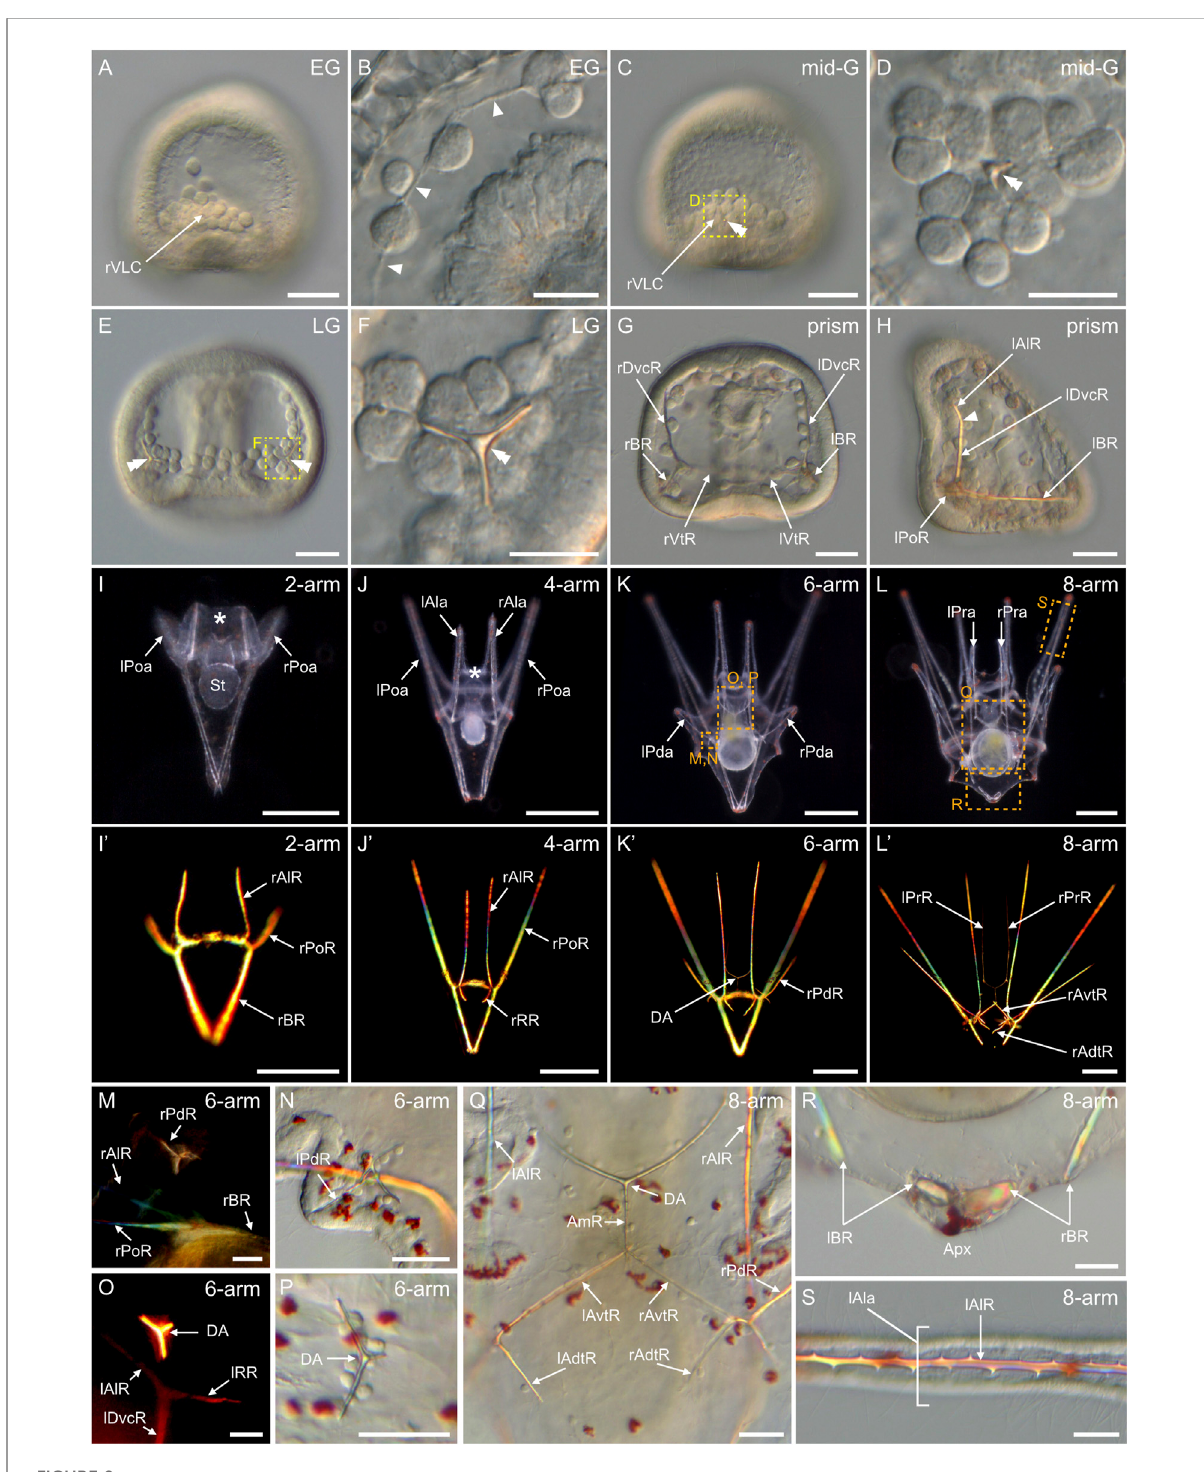
FIGURE 9 Skeletogenesis in Paracentrotus lividus during the embryonic and larval periods. Developmental stages are as follows: (A,B) early gastrula stage (EG); (C,D) mid-gastrula stage (mid-G); (E,F) late gastrula stage (LG); (G,H) prism stage(prism); (I,I ’ ) 2-arm pluteus stage (2-arm); (J,J 9 ) 4-arm pluteus stage (4-arm); (K,K ’ ,M – P) 6-arm pluteus stage (6-arm); (L,L ’ ,Q – S) 8-arm pluteus stage (8-arm). In (A – L,N,P – S) , images were acquired using light microscopy either in bright- fi eld for (A – H,N,P – S) , or dark- fi eld for (I – L) . In (I ’– L ’ ,M,O) , images were obtained using polarized light to highlight the skeletal elements. In (A,C,H) , embryos are in right view, with the animal pole up and, for (H) , with the ventral side left. In (E,G) , embryos are in